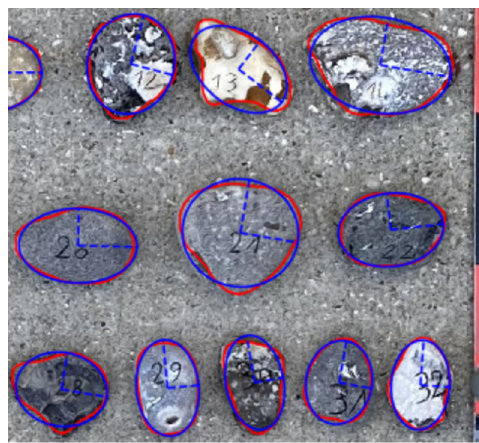
Figure 3. Comparison between sediment particles’ shape as detected with Mask R-CNN (red) and the ellipse fitted around this shape (blue). The ellipses’ major and minor axes are displayed as dashed blue lines.